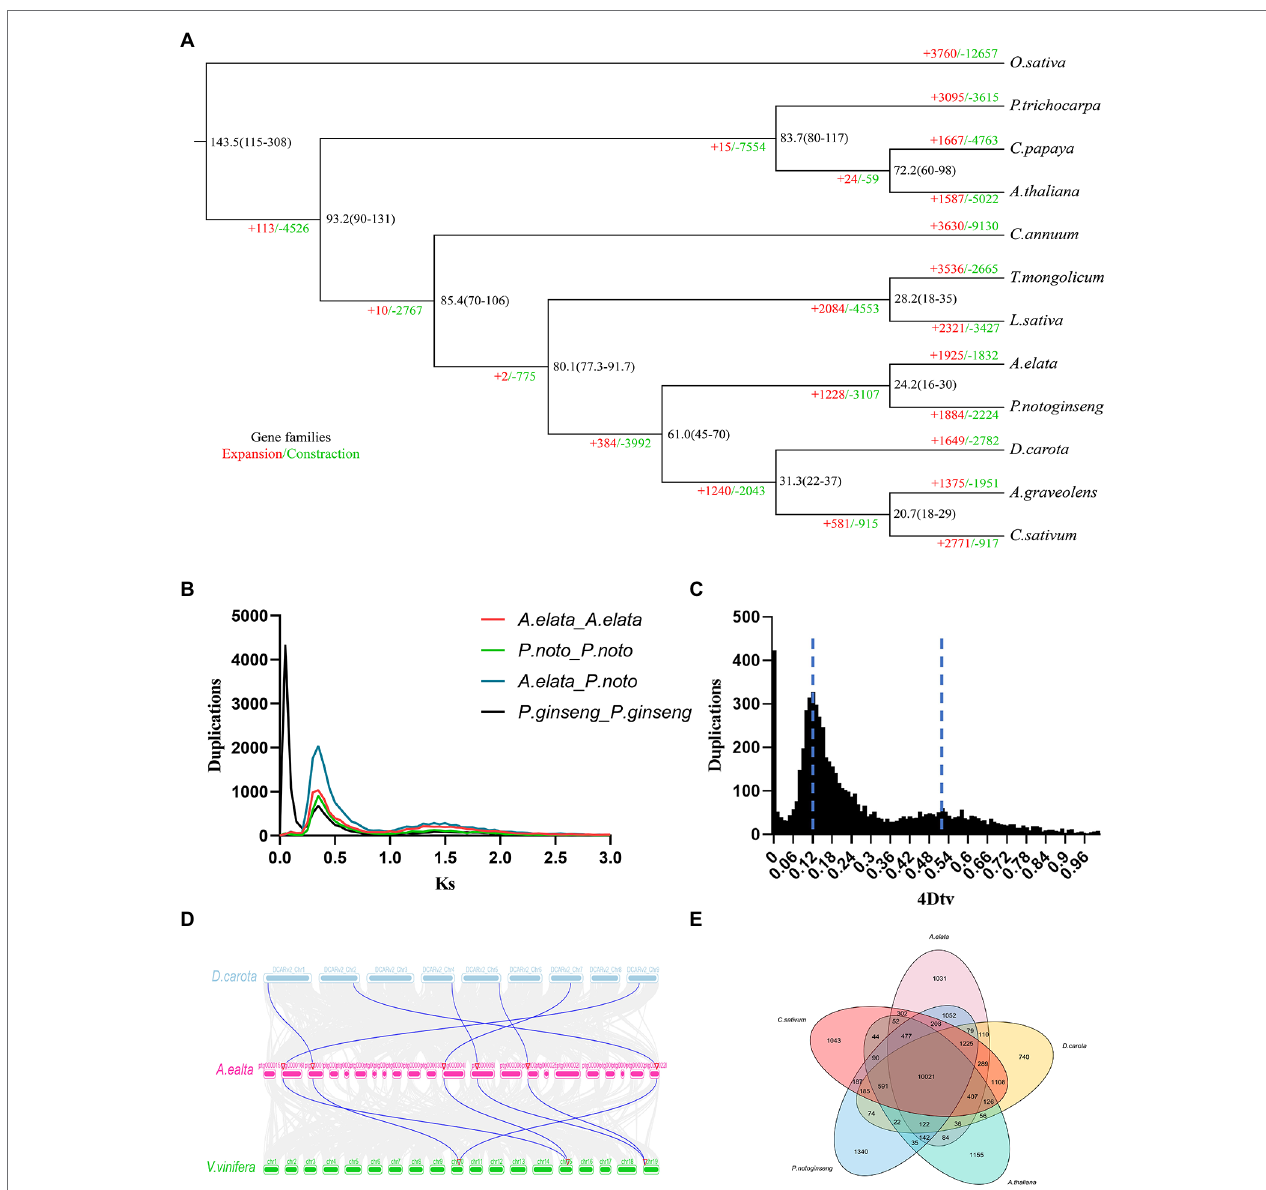
FIGURE 2 | (A) Inferred phylogenetic tree of Aralia elata and 11 plant species based on protein sequences of single-copy orthologous genes. Numbers at each node represent the estimated divergence time of each node in million years ago (mya). Gene family expansions are indicated in red, and gene family contractions are indicated in green. (B) Ks distribution of paralogous gene pairs in the A. elata , Panax notoginseng , and Panax ginseng genome. The probability density of Ks was estimated using the “density” function in the R language. (C) Distribution diagram of 4DTv values. The dark black-filled part indicates the 4DTv analysis inside A. elata , and the peaks marked by the dotted line indicate where the two whole genome duplication (WGD) events of A. elata occurred. (D) Collinear analysis among Daucus carota , A. elata , and Vitis vinifera genome. The blue lines in the genomes of A. elata and V. vinifera indicate that the 2:1 correspondence between the two collinear regions. (E) Venn diagram showing the cluster distribution of shared gene families among A. elata , C. sativum , P. notoginseng , D. carota , and A. thaliana